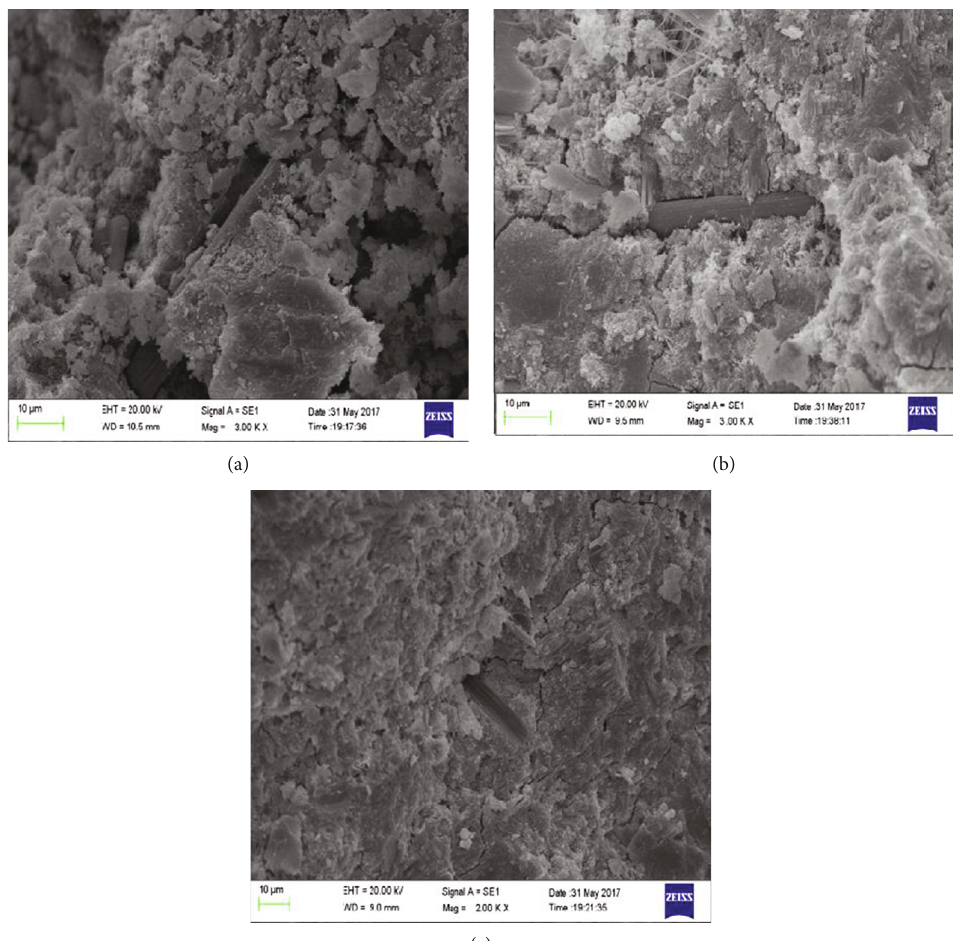
Figure 7: SEM image of cement stone after curing for 7 days with 0.2% CF